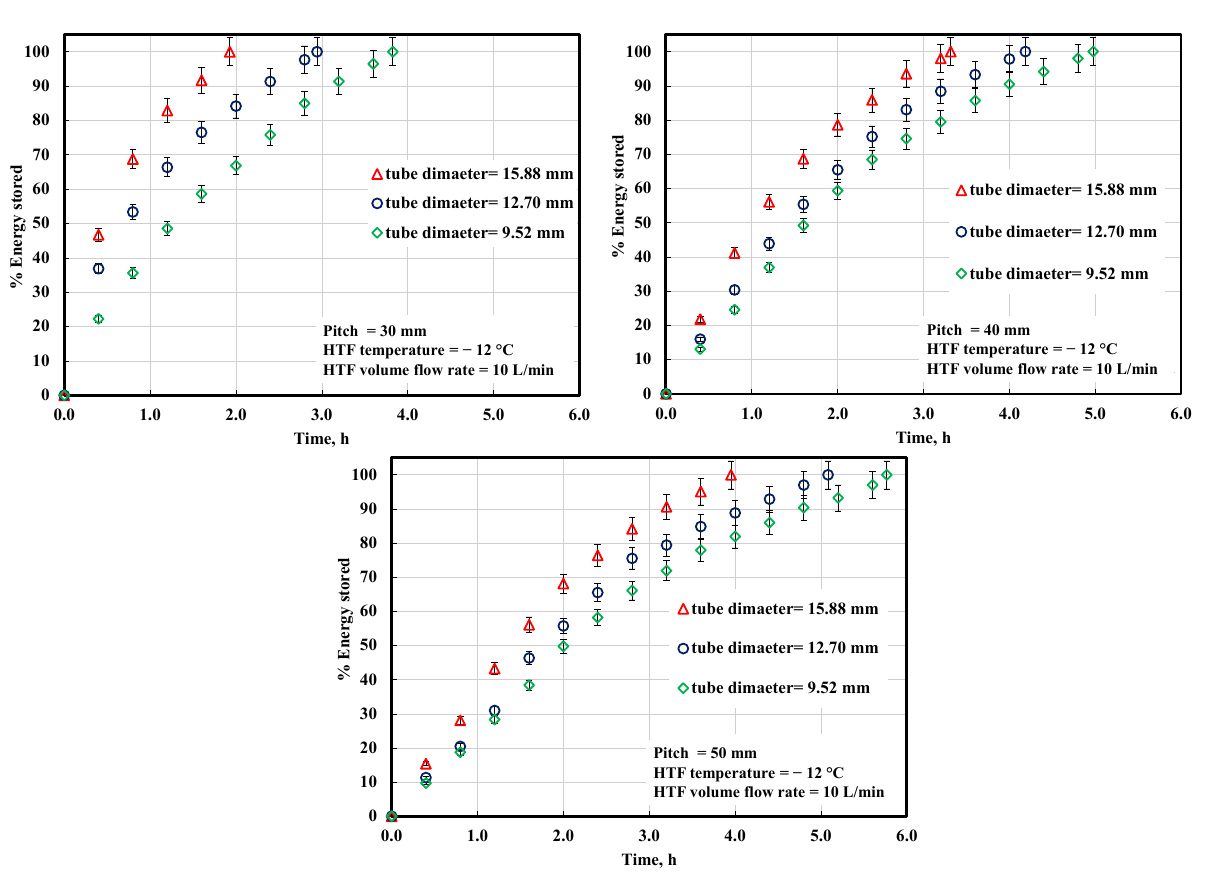
Figure 7. Effect of tube diameters on the energy stored percentage versus time using three pitches during the charging process.